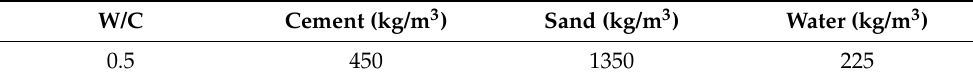
Table 1. Mortar composition.